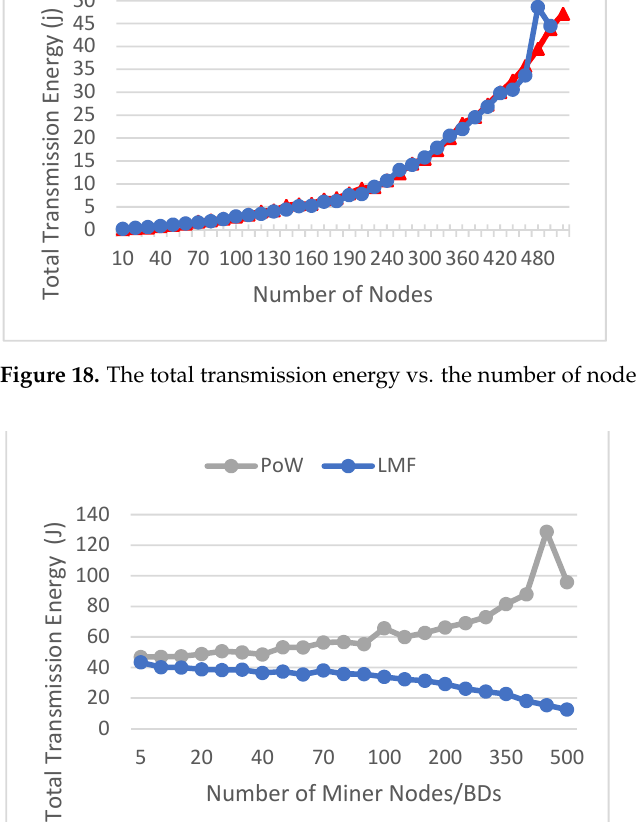
Figure 19. The total transmission energy vs. the total number of miners/BDs on the PoW and LMF models.